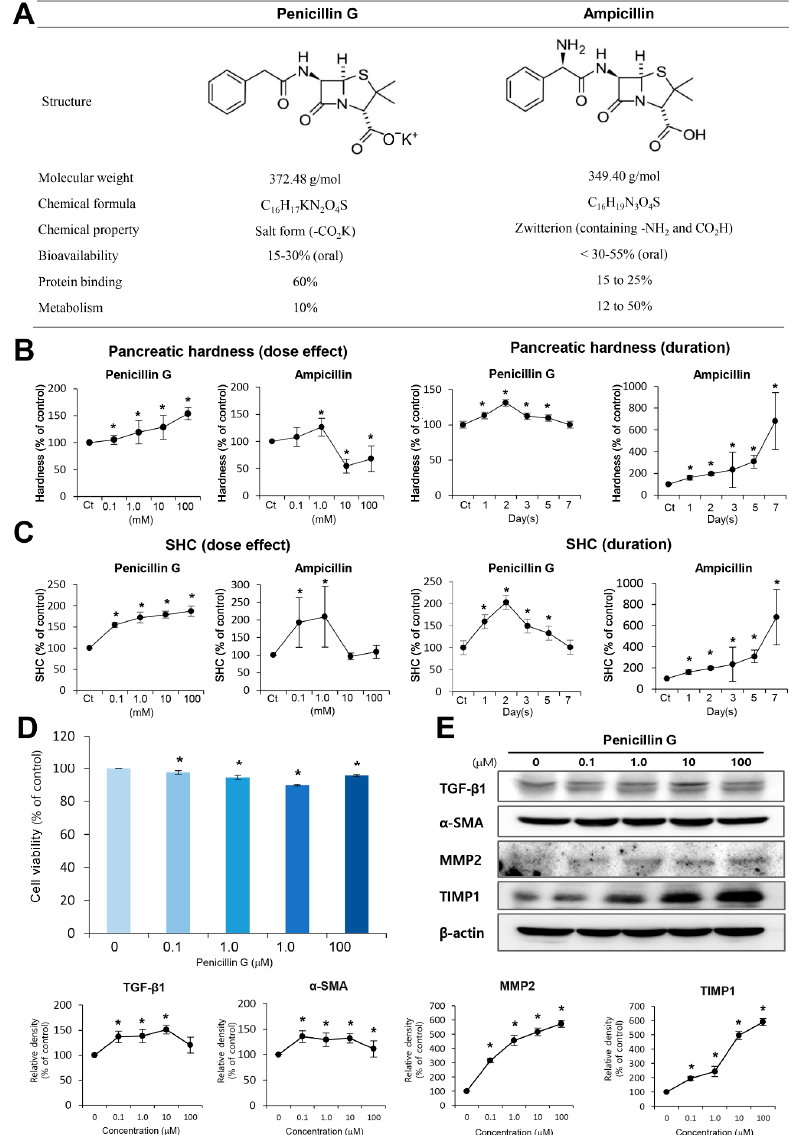
Figure 1. Comparison of pancreas-hardening capacity and SHC between penicillin G and ampicillin. ( A ) Molecular structure of penicillin G (Left) and ampicillin (Right). Ampicillin differs from penicillin G only by the presence of an amino group. ( B ) Pancreas-hardening capacity between penicillin G and ampicillin. [Top] Dose-dependent effects of penicillin G (Left) and ampicillin (Right)